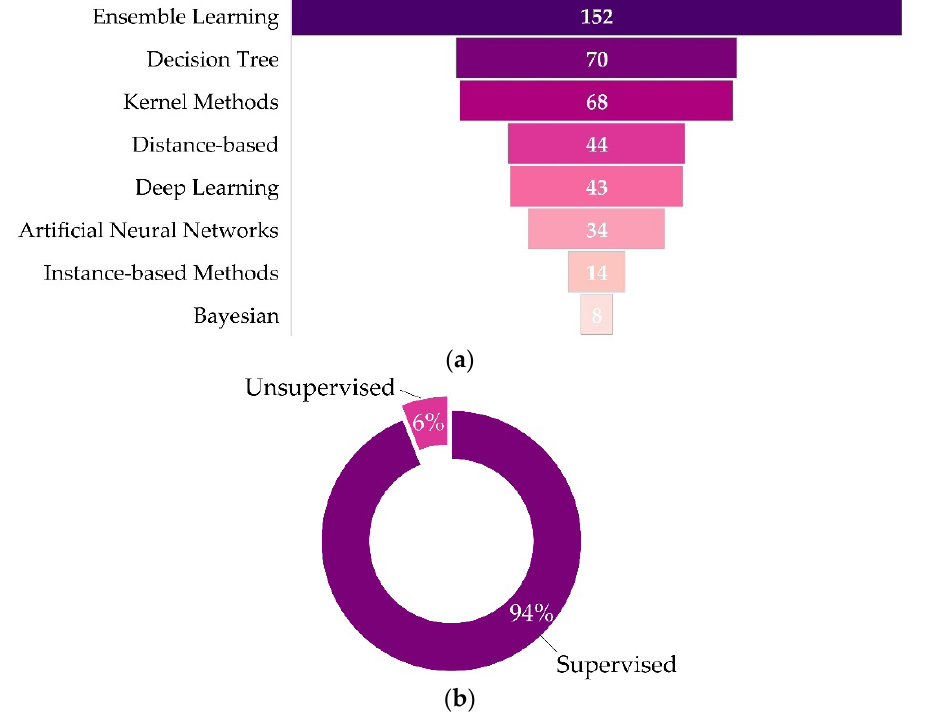
Figure 15. ( a ) Frequency of ML algorithms in wetland studies with ( b ) percentage of supervised and unsupervised approaches.